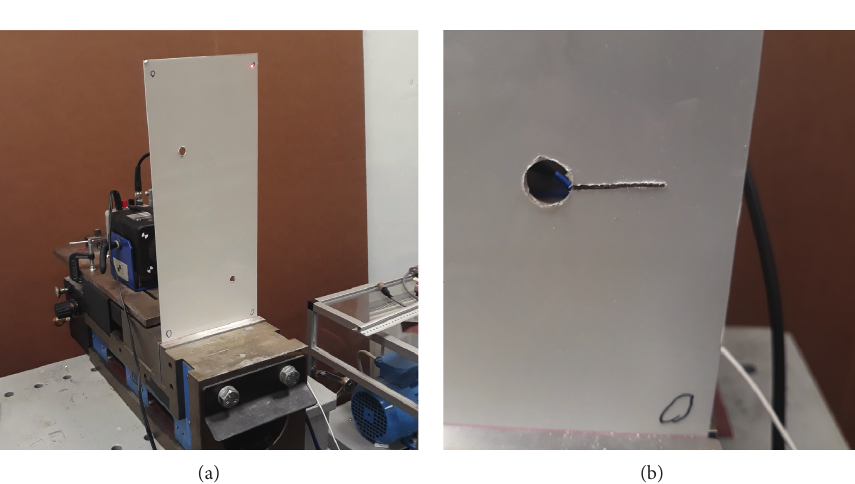
Figure 9: Damage introduced to the specimen in laboratory experiment: (a) specimen clamped in front of the vibrometer with two kinds of damage present and (b) close-up of the first damage with third damage halfway